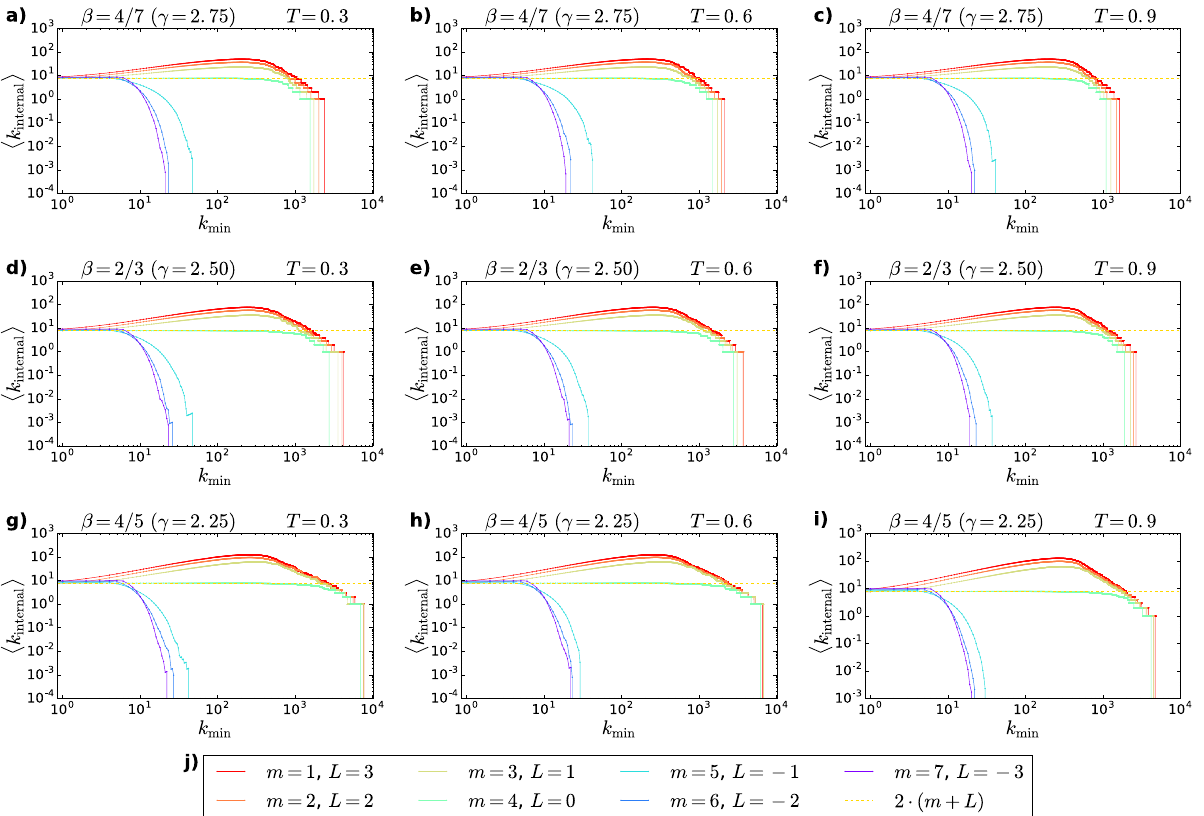
Figure 1. Average internal degree of subgraphs spanning between nodes with degrees larger than a threshold as a function of the degree threshold for synthetic networks generated by the E-PSO model using different 100, 000 . The parameter parameters. With each parameter setting one network was generated with size N = T setting given in the title of the subplot. The ζ was always set to 1. Each panel corresponds to a certain β − different colours of the curves indicate the different settings of the parameters m and L , as listed in panel j). The L ) was 8 for each 2 ( m expected average degree < k > = · +